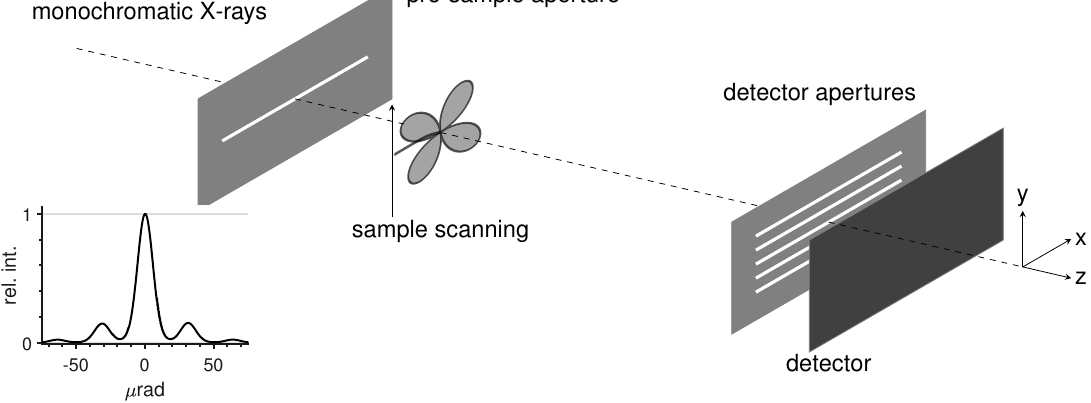
Figure 1. Sketch of the set-up: 20 keV monochromatic synchrotron radiation is amplitude-modulated with a narrow slit, traverses the sample and is analysed by a set of apertures just before the detector. The sample is scanned along the vertical (y) direction and a two-dimensional image is built line-by-line. The illumination function is shown in the inset in the bottom left